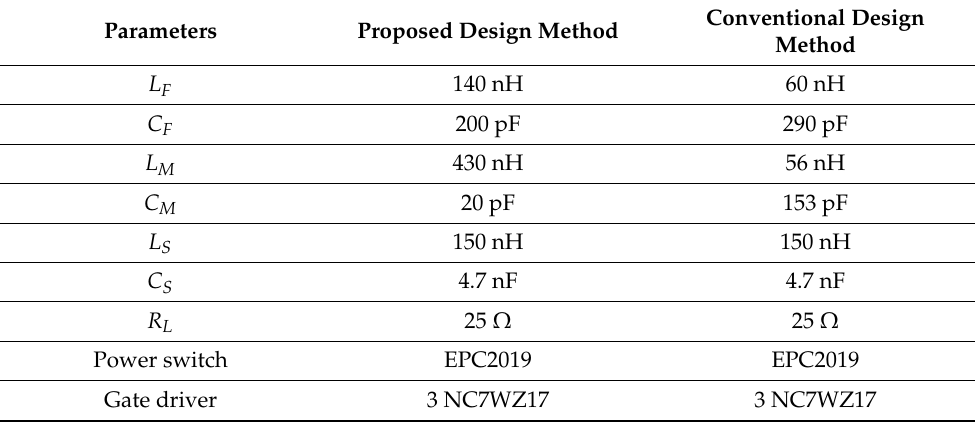
Figure 12. Class Φ 2 inverter prototypes with different design methods: ( a ) proposed method; Figure 12. Class Ф 2 inverter prototypes with different design methods: ( a ) proposed method; ( b ) conventional design method. ( b ) conventional design method. Table 5. Circuit parameters with different design methods. Table 5. Circuit parameters with different design methods.